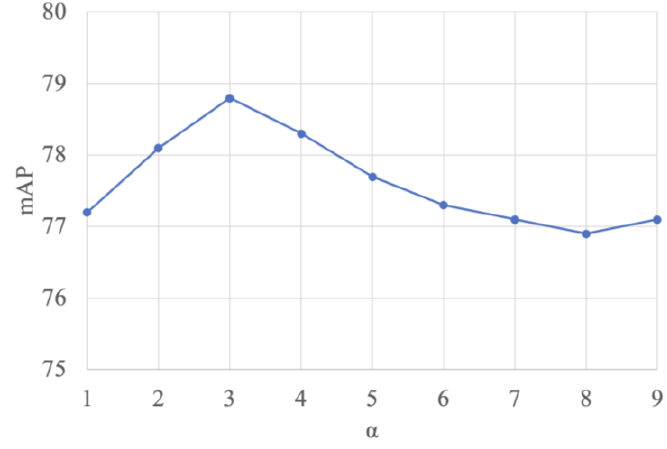
Figure 6. Variation in accuracy for different values of α on the algorithm.